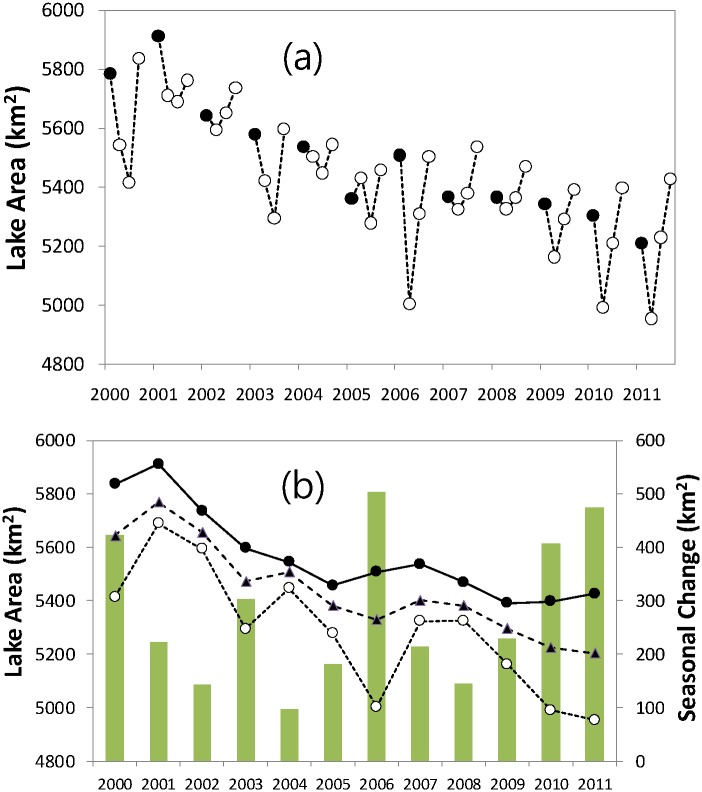
Seasonal (June-to-September) and inter-annual variations of total lake surface areas (km2) detected based on MODIS minimum composite NDVI from 2000 to 2011.(a) monthly lake surface area, (b) annual maximum (closed circle), minimum (open circle), and mean (triangle) lake areas with annual range (vertical bar) of seasonal lake area change. Lake areas are shown only for June to September. Closed circle in (a) indicate the lake area in June of each year.